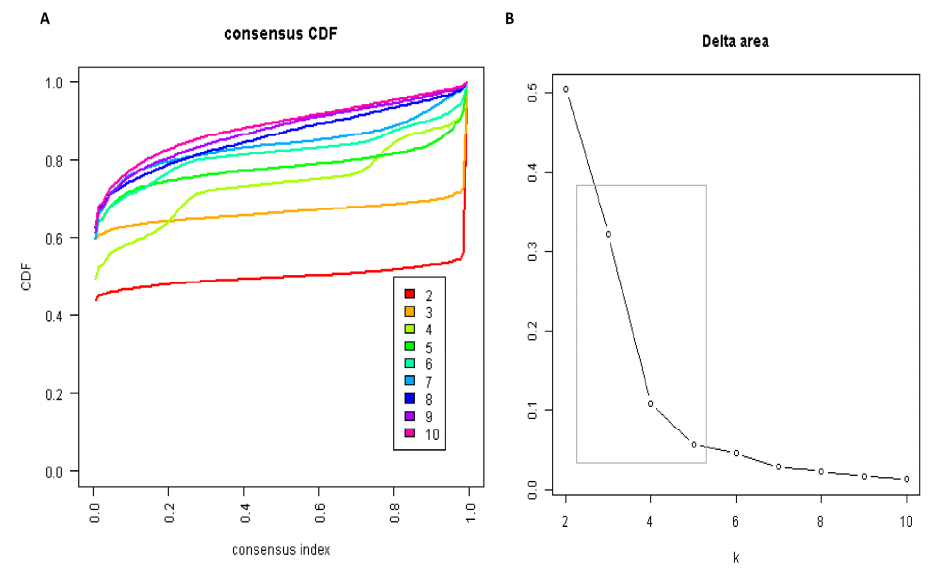
Figure 1. ( A ) CDF plot displaying consensus distributions for each k; ( B ) Delta area plot reflecting the relative changes in the area under the CDF curve.